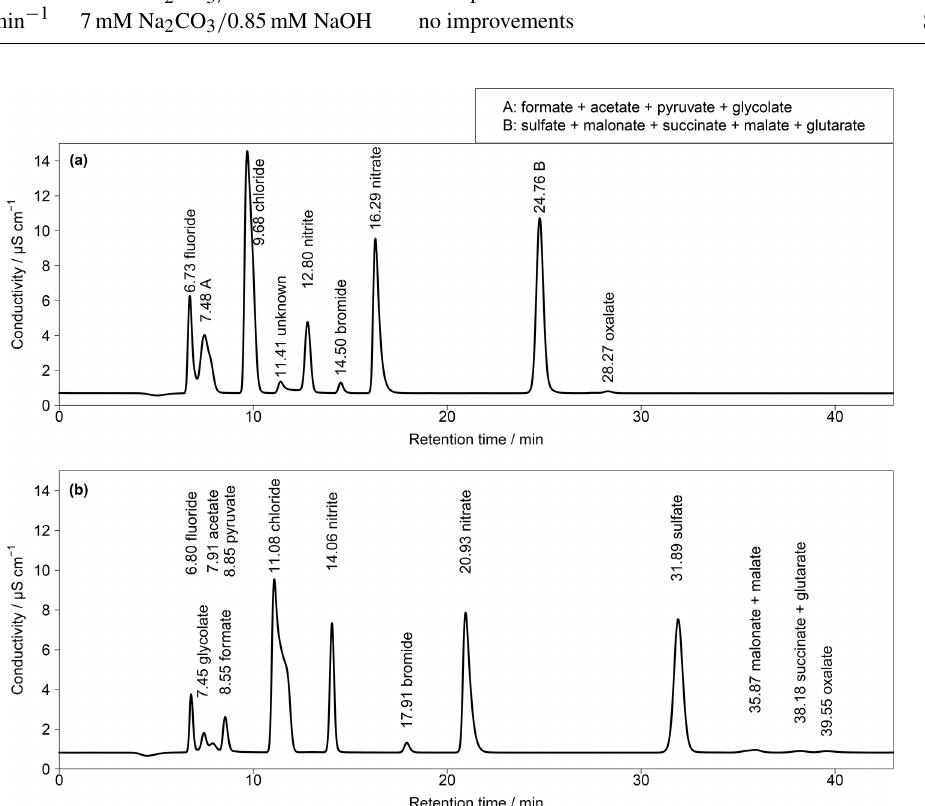
Figure 3. (a) Isocratic chromatogram for Shodex IC SI-50 4E with a standard solution of 50µgL − 1 for Cl − , NO − NO − ; 5µgL − 1 for F − and Br − ; and 2µgL − 1 for all organic acids ( T = 30 ◦ C, eluent flow = 0.7mLmin − 1 ). (b) Isocratic chromatogram 2 for Metrosep A Supp 7 with a standard solution of 50µgL − 1 for Cl − , NO − 3µgL − 1 for all organic acids ( T = 45 ◦ C, eluent flow = 0.8mLmin − 1 ). Numbers in front of the ion names indicate the retention times in